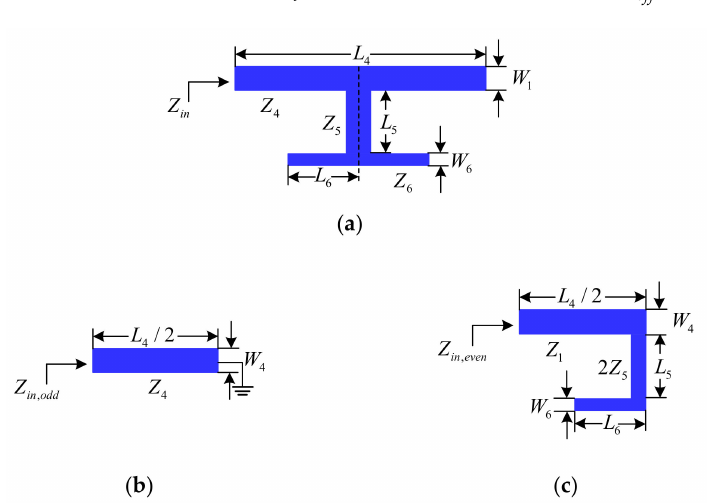
Figure 3. Schematic of the dual-mode open-circuit stub-loaded resonator: ( a ) dual-mode resonator; ( b ) odd-mode; and ( c )